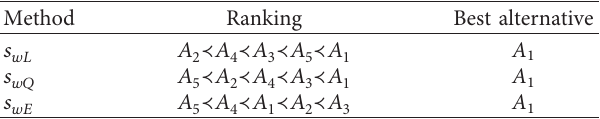
Table 7: Ranking order of alternatives for different similarity methods. Method